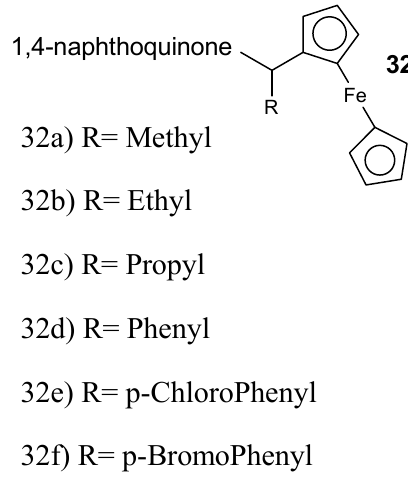
Figure 17. Structure of ferrocene–pyrimidine hybrid molecule 33 .